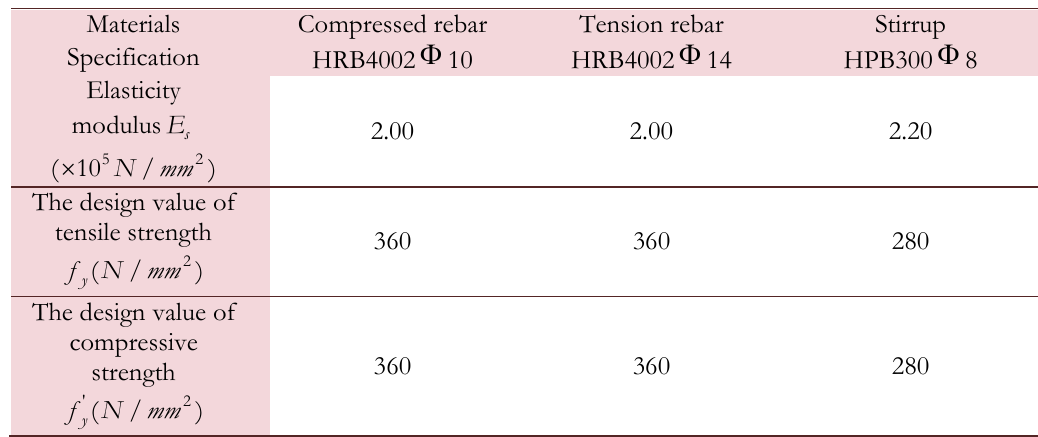
Table 1: The parameters of